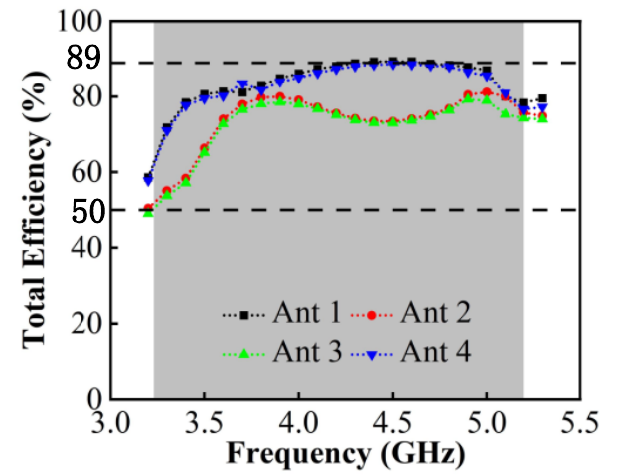
Figure 17. Measured total efficiency.